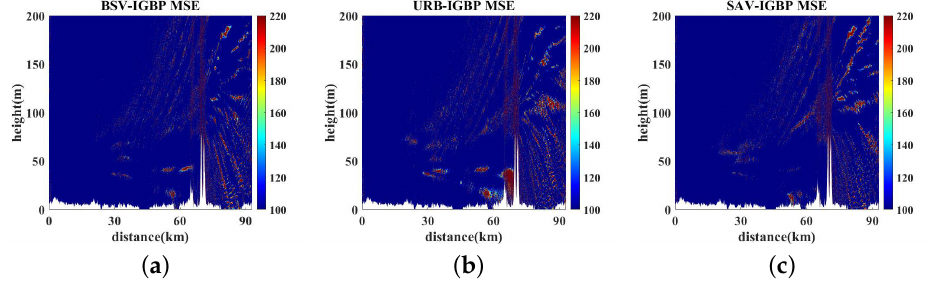
Figure 24. The MSE of PL using the improved TWPE between IGBP LC and different LCs on